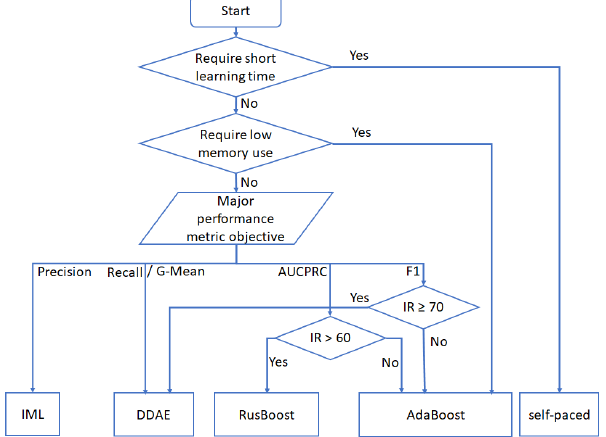
Figure 26. Our recommendation for algorithm selection based on experimental results in this